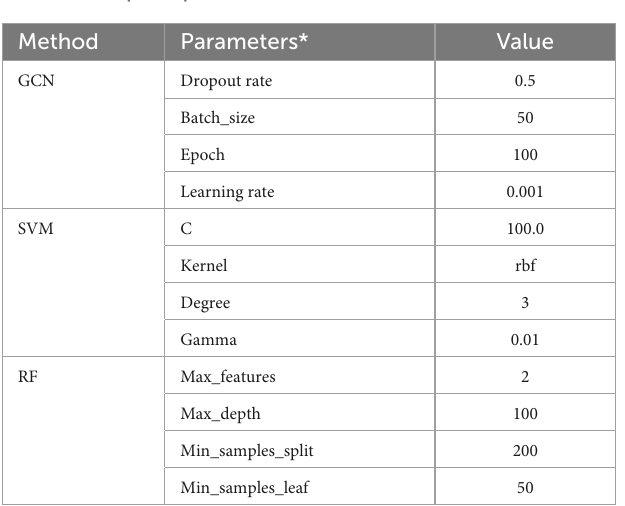
TABLE 5 Comparison of brain network sizes with different